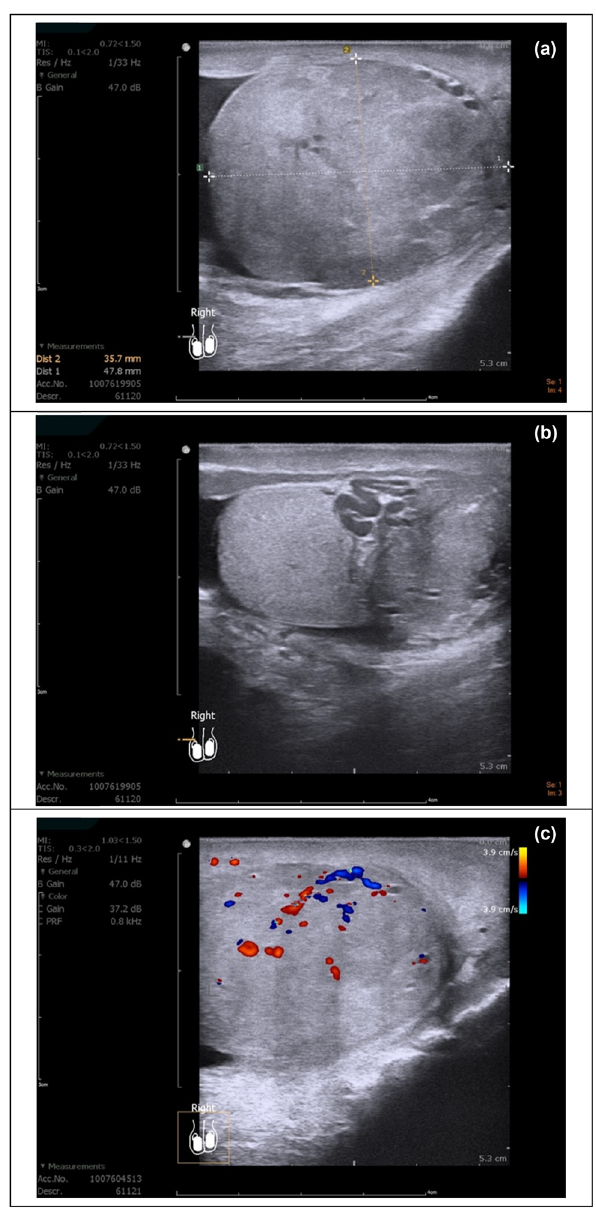
Figure 1: Ultrasound sonography: ( a ) a well - capsulated heteroe - choic round mass over the tail of epididymis, 4.7 × 3.5 cm in size, and ( b ) abundant tortuous vessels adjacent to the paratesticular tumor. ( c ) The tumor had a rich blood supply on color Doppler